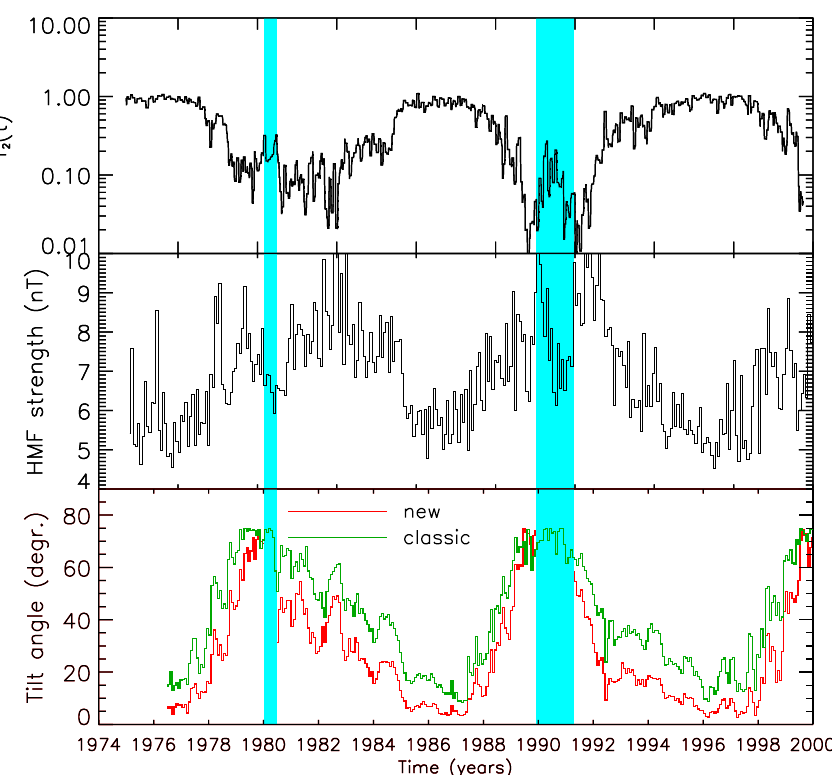
Fig. 1. Top panel: The function f 2 (t) in Eq. (2) represents the time-dependence of all the heliospheric diffusion coefficients for the period 1975 up to 2000. This function combines the effects of the observed global changes in the heliospheric magnetic field (HMF) magnitude (middle panel; NSSDC COHOWeb: http://nssdc.gfc.nasa.gov/cohoweb) with drifts, therefore also time dependent current sheet “tilt angles” (bottom panel; Wilcox Solar Observatory: http://quake.stanford.edu/), to establish the time-dependence of the diffusion